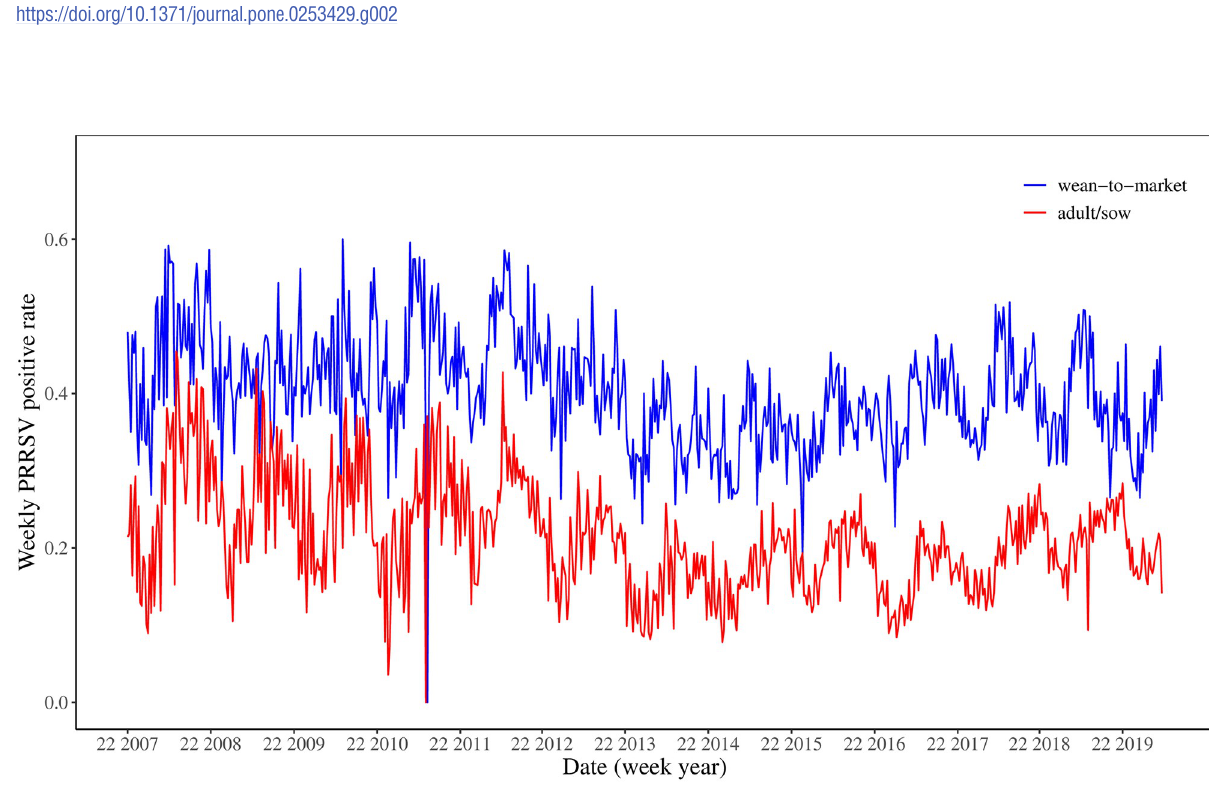
PLOS ONE | https://doi.org/10.1371/journal.pone.0253429 July 2, 2021 4 /